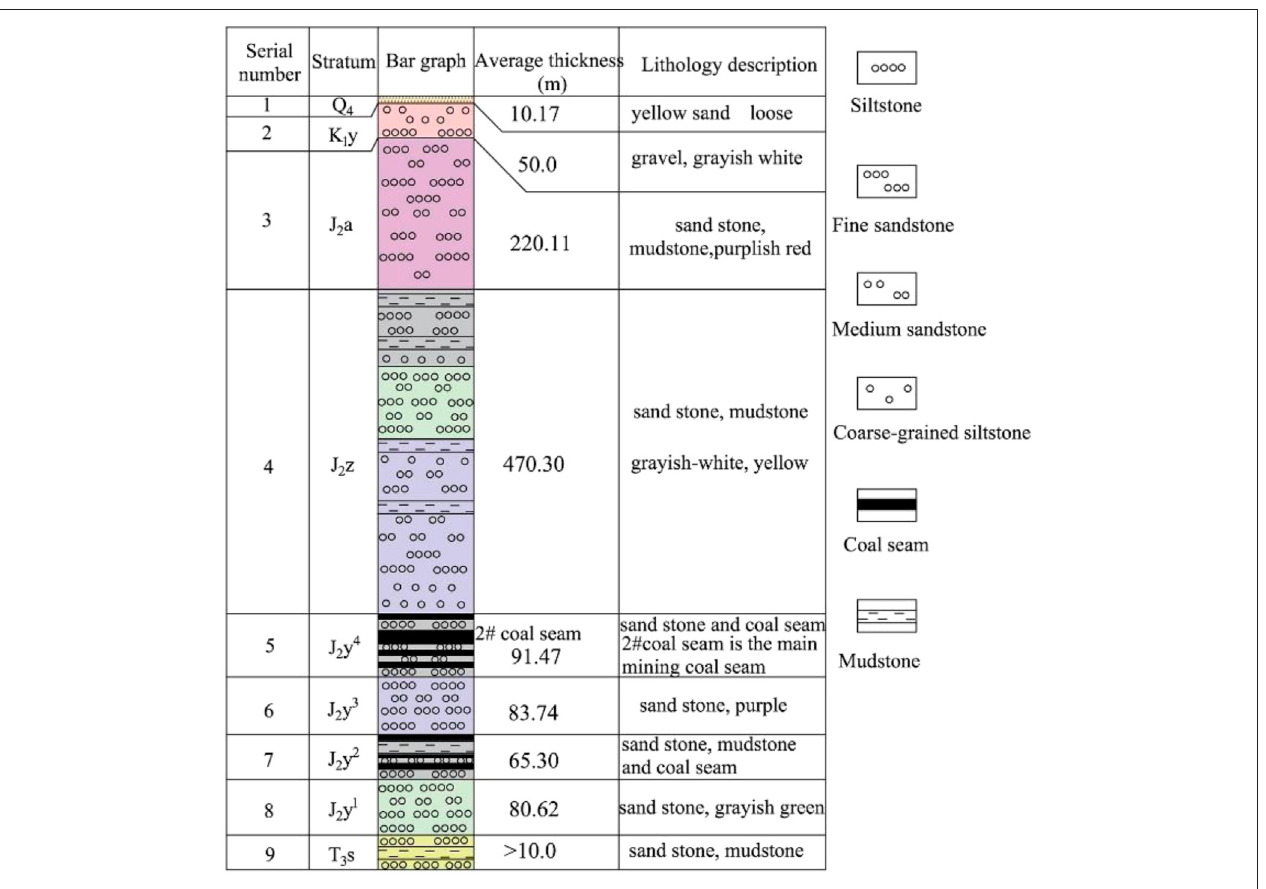
FIGURE 2 | The overburden strata histogram of the 2 # coal seam.